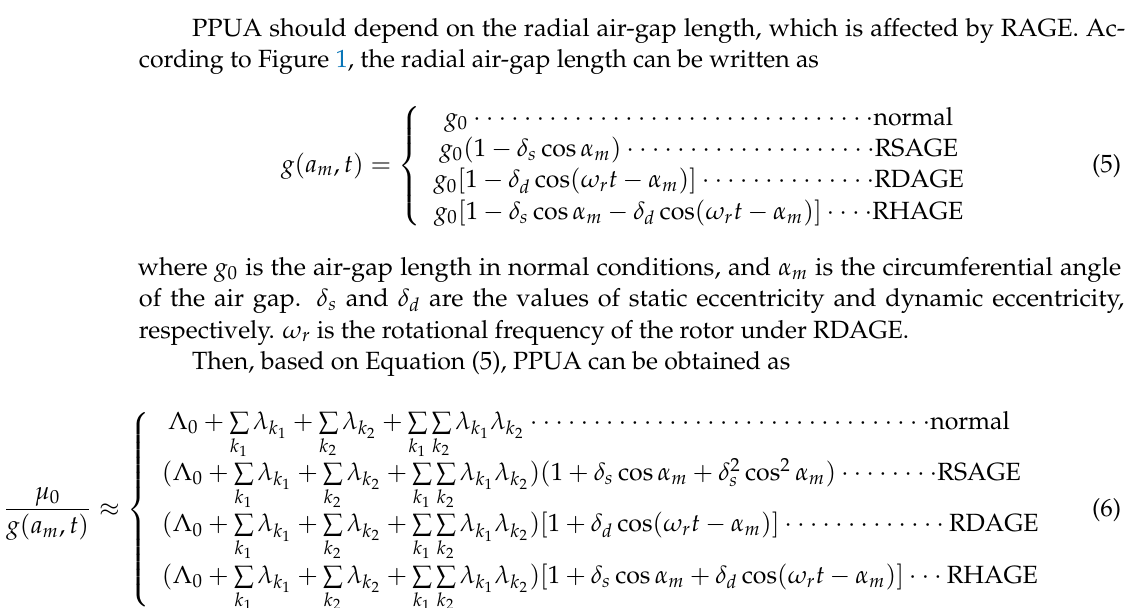
Figure 2. Air-gap of generator: ( a ) normal; ( b ) RSAGE; ( c ) RDAGE; ( d )